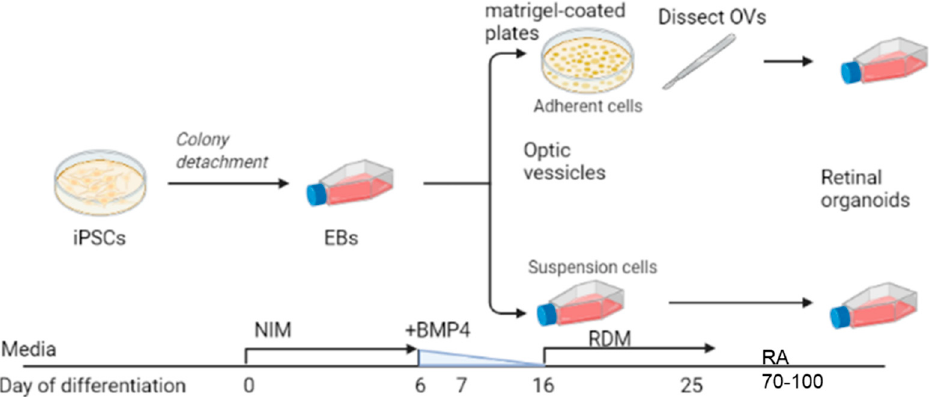
Figure 1. Scheme illustrating dissection vs. suspension differentiation protocols. Embryoid bodies, EBs; Neural induction media, NIM; bone morphogenic protein-4, BMP4; retinal differentiation media, RDM; retinoic acid, RA; optic vesicles, OVs. Image created with Biorender.